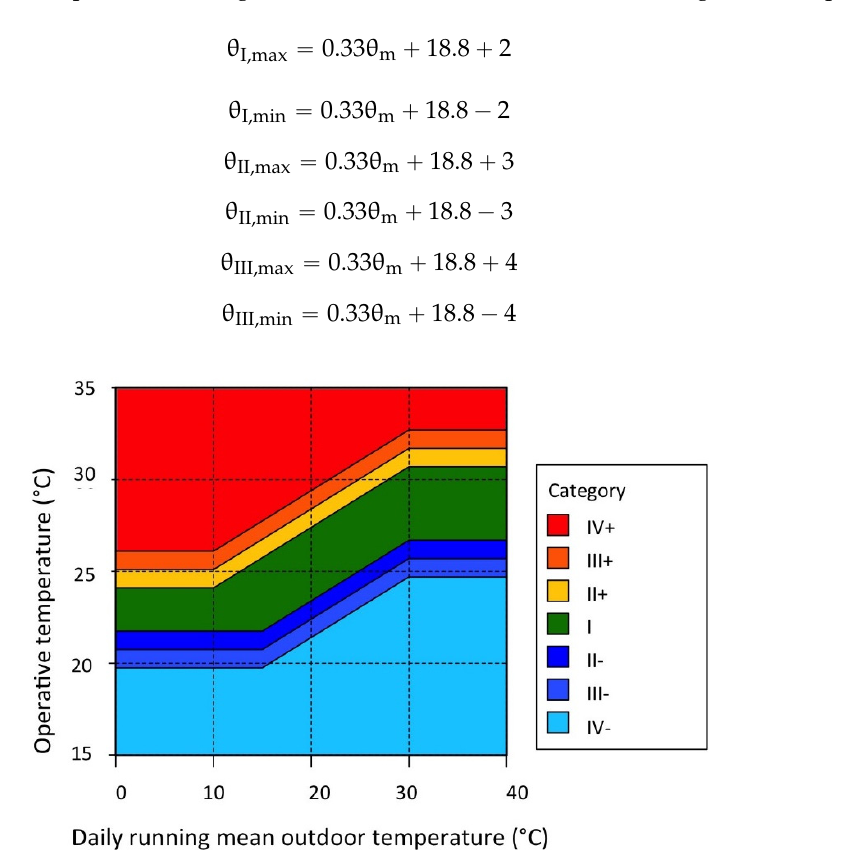
Figure 3. Thermal comfort categories for the operating temperature in naturally ‐ ventilated buildings, according to the European standard (NF ‐ EN) 15251 Standard [31].